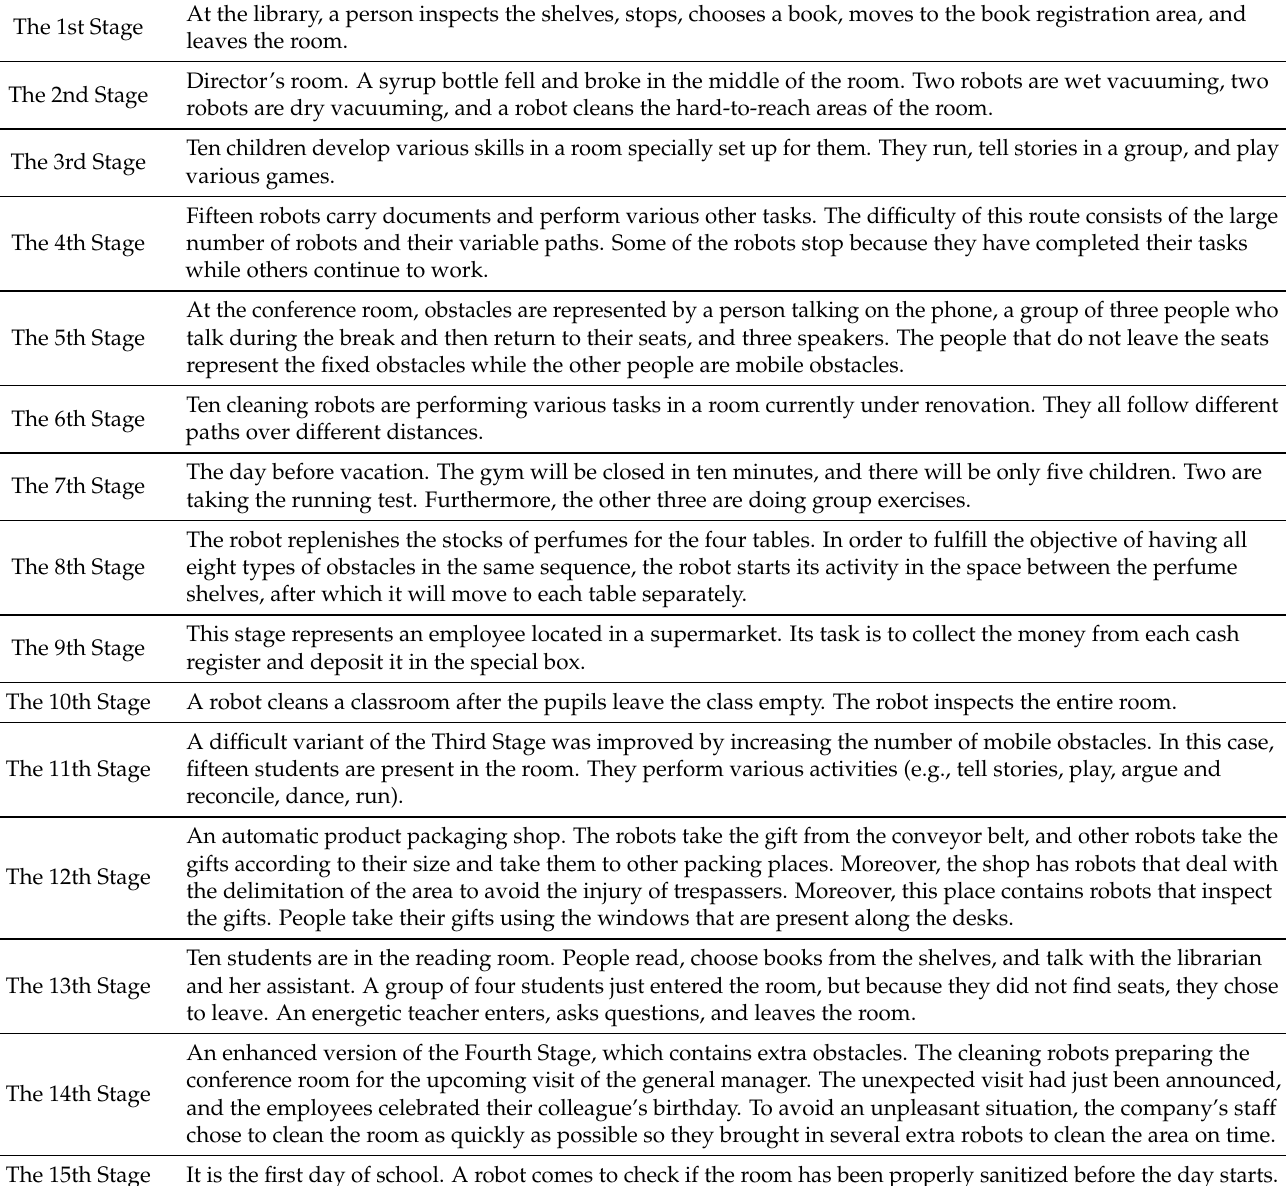
Table 2. The full description of the simulations created in